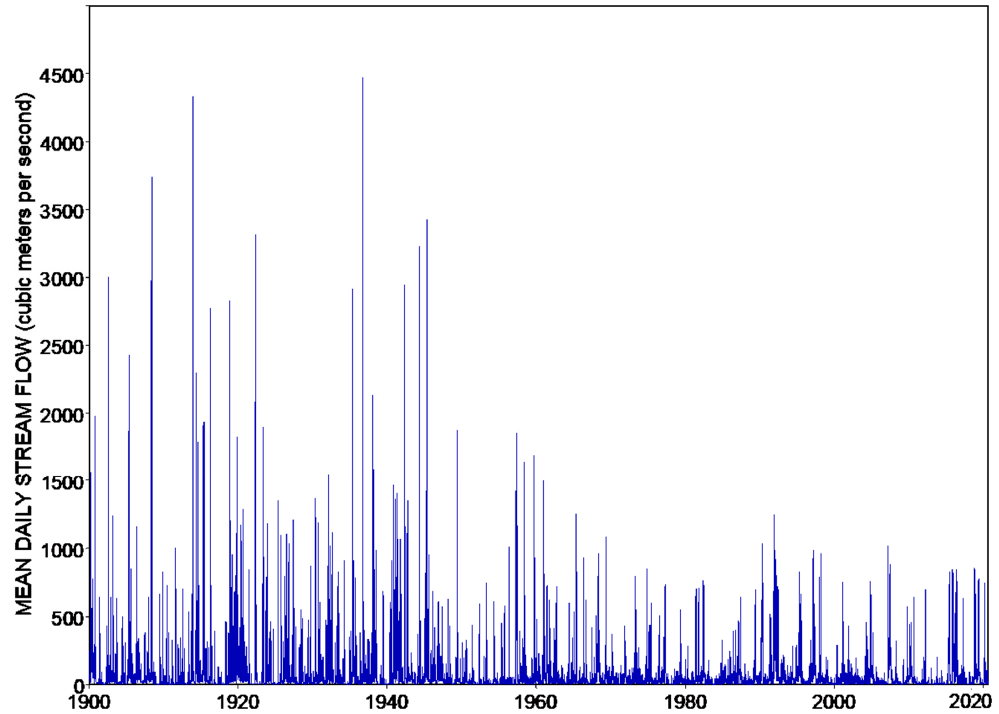
Figure 3. January 1900 through July 2020 daily flow of Brazos River at Waco gauge.